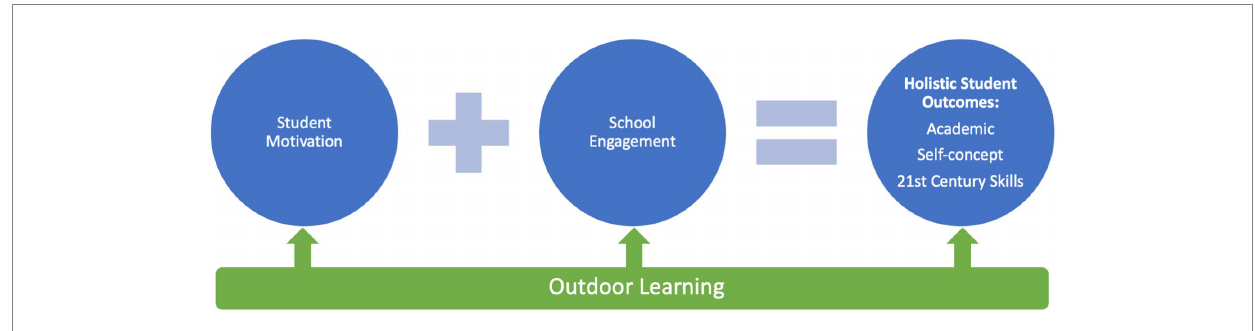
FIGURE 1 Hypothesized boosting effect of outdoor learning on student motivation, school engagement, and holistic student